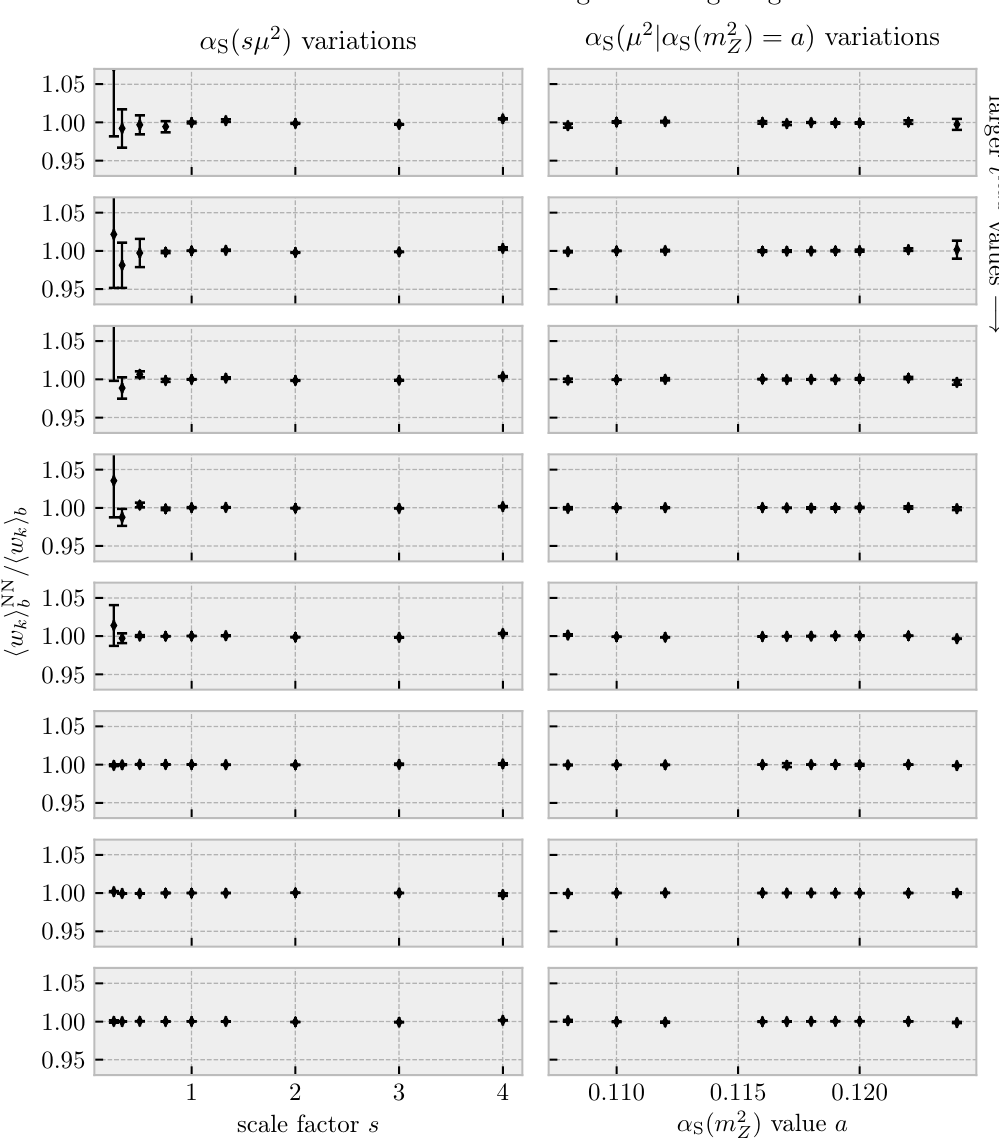
Figure 4 . Ratios between neural-net-predicted and true reweighting factors for each bin of the t lead histogram, see (cid:12)gure 3. Each row corresponds to one bin, with the smallest- t lead bin at the top. The two columns correspond to scale and (cid:11) S ( m 2